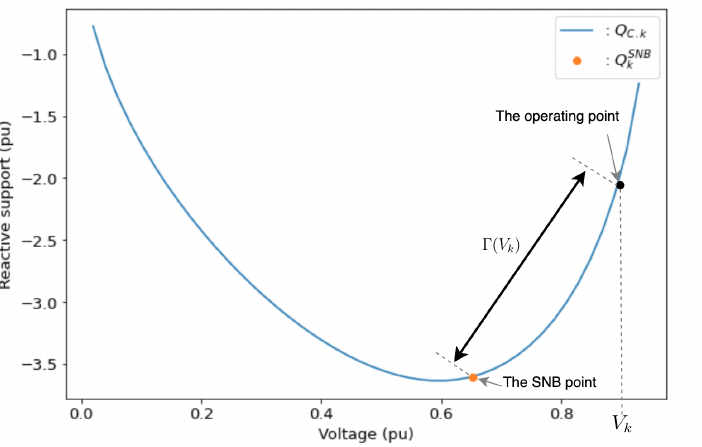
Figure 1. An example of reactive support variation at different voltage levels with parameter description for estimating vulnerable buses of voltage